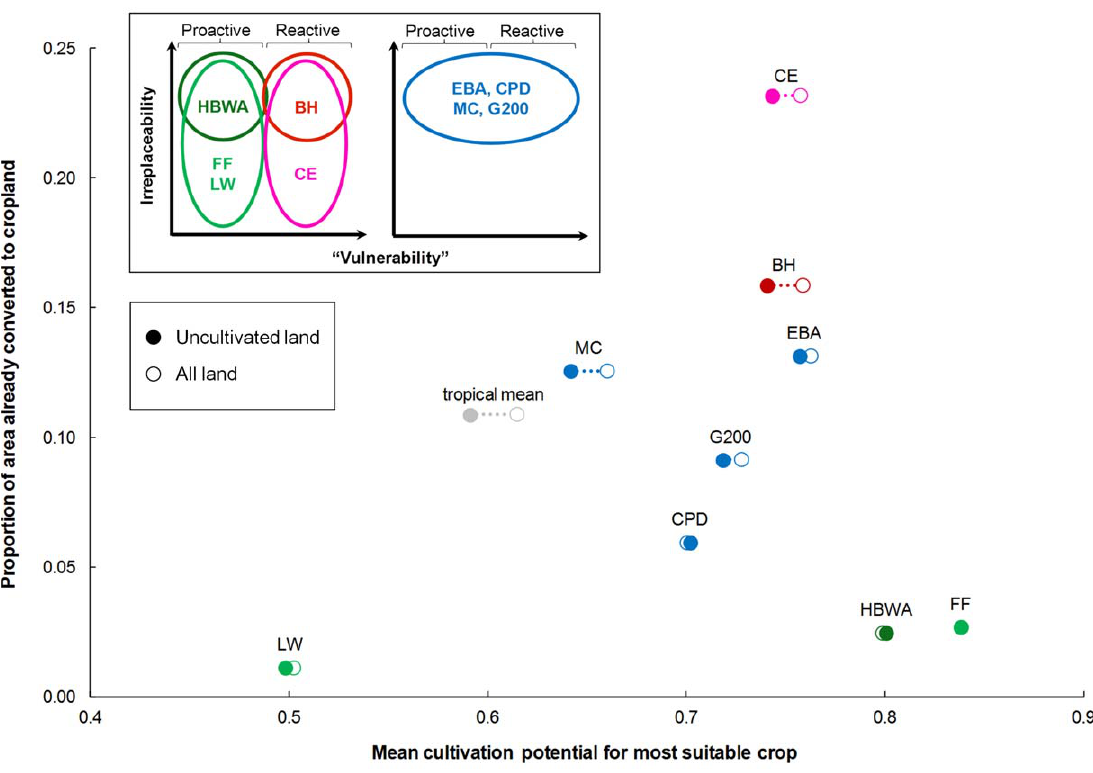
Figure 7. Cropland extent and cultivation potential within priority areas for biodiversity conservation in tropical countries. Cultivation potential is defined as in Figure 5. The open symbols show the mean cultivation potential of all land in each set of priority areas, while the filled symbols show the mean cultivation potential of land that had not yet been converted to cropland as of 2000. Inset from [30] shows conservation priority templates placed within the conceptual framework of irreplaceability and (retrospective) ‘‘vulnerability’’ and coloured accordingly (reprinted with modification, with permission from AAAS). ‘‘Proactive’’ conservation priorities are those in areas which are not yet considered to be highly ‘‘vulnerable’’ to conversion, while ‘‘reactive’’ priorities are those in areas where there has already been much habitat conversion. Abbreviations: Biodiversity Hotspots (BH), Centres of Plant Diversity (CPD), Crisis Ecoregions (CE), Endemic Bird Areas (EBA), Frontier Forests (FF), Global 200 Ecoregions (G200), High Biodiversity Wilderness Areas (HBWA), Last of the Wild (LW), Megadiversity Countries (MC). Mean across all tropical countries shown by grey symbols.